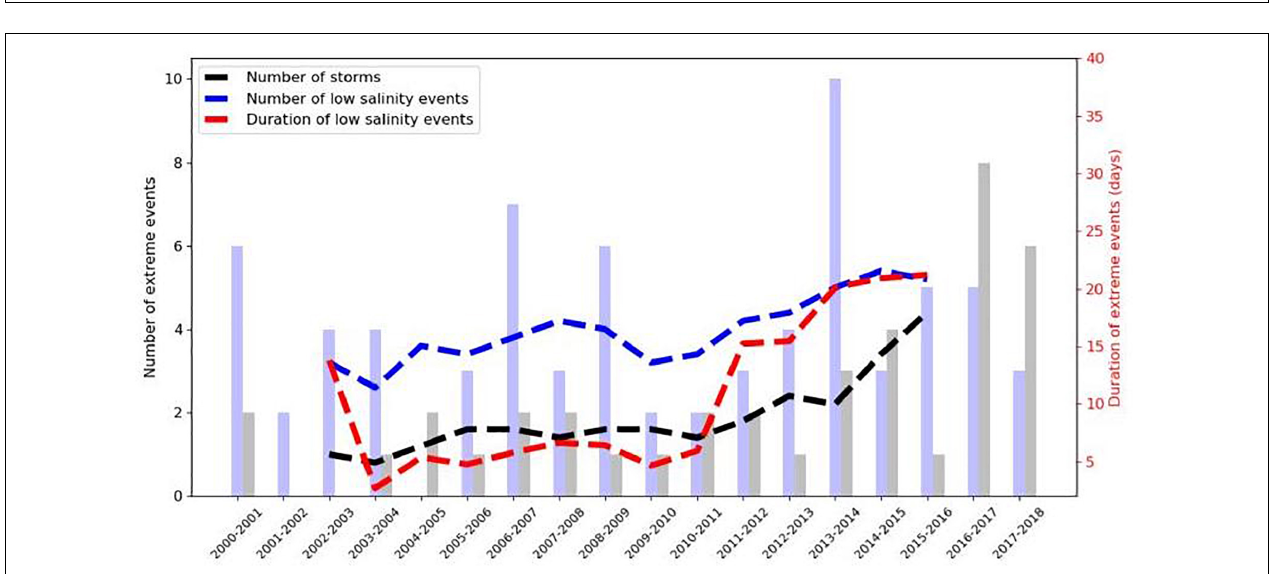
FIGURE 7 | Interannual changes (after application of a 5-years running mean) in the number of extreme weather episodes (in black) with its raw data (in grey), in situ extreme low salinity events (in blue) with its raw data (in light blue) and their duration (in days, in red) at the COAST-HF-Iroise buoy.